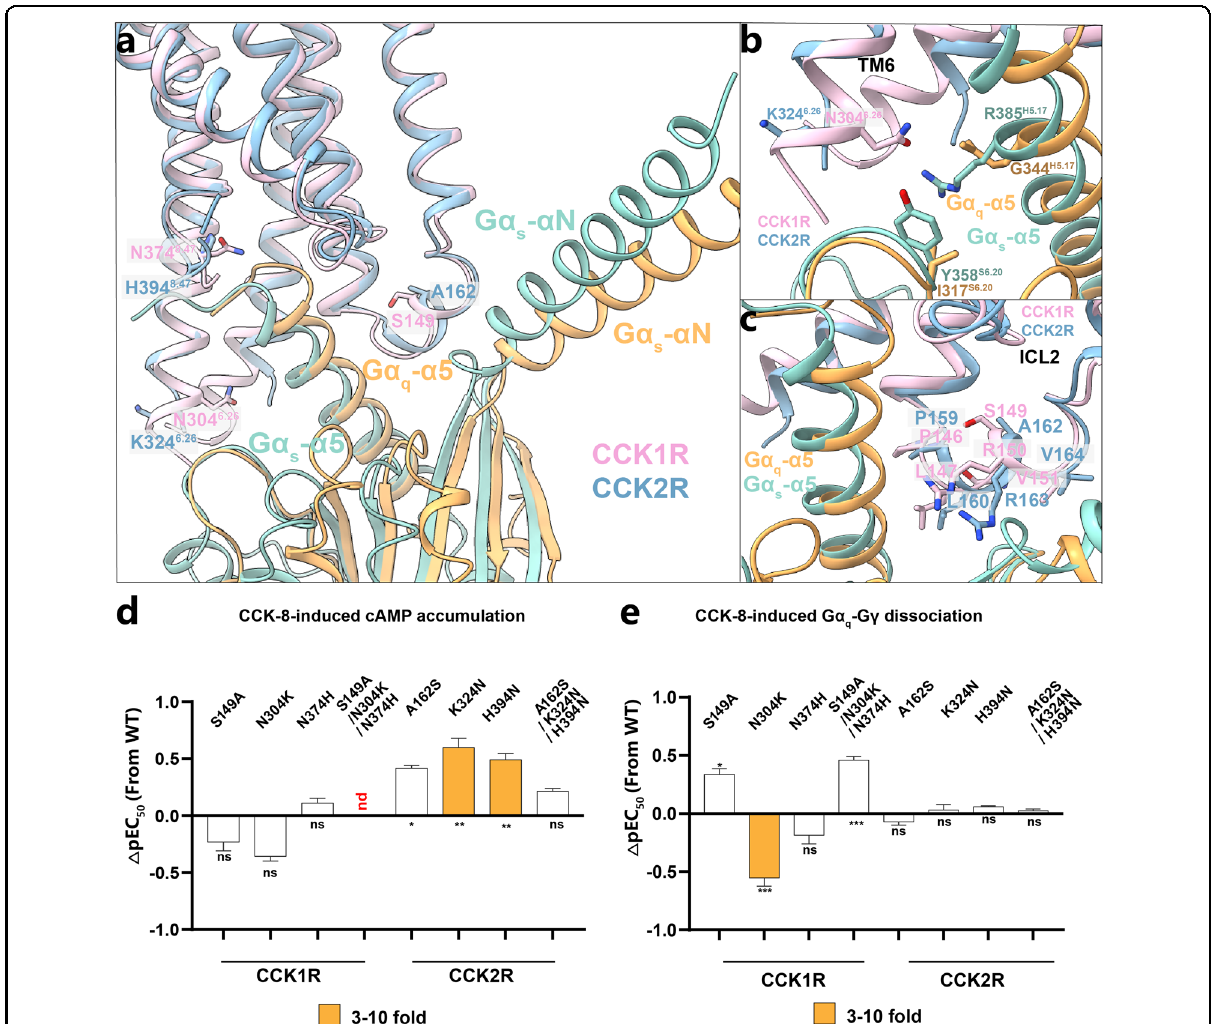
Fig. 7 G protein subtype speci fi city between CCK1R and CCK2R. a Comparison of G protein conformations in SR146131 – CCK1R (pink) – G α s (cyan) and CCK-8 – CCK2R (blue) – G α q (orange) structures. b Interactions between N304 6.26 in CCK1R (pink) and R385 H5.17 and R358 S6.20 in G α S (cyan). The corresponding residues in CCK2R (blue) and G α q (orange) are also shown. c Detailed interactions between ICL2 of CCK1R (pink) and G α s (cyan) and between ICL2 of CCK2R (blue) and G α q (orange). d , e Residues involved in G protein coupling in CCK1R/CCK2R are respectively substituted by the corresponding residues in CCK2R/CCK1R, and the effect of each single- or triple-mutation on CCK-8-induced cAMP accumulation ( d ) or CCK-8- induced G α q – G γ dissociation ( e ) is